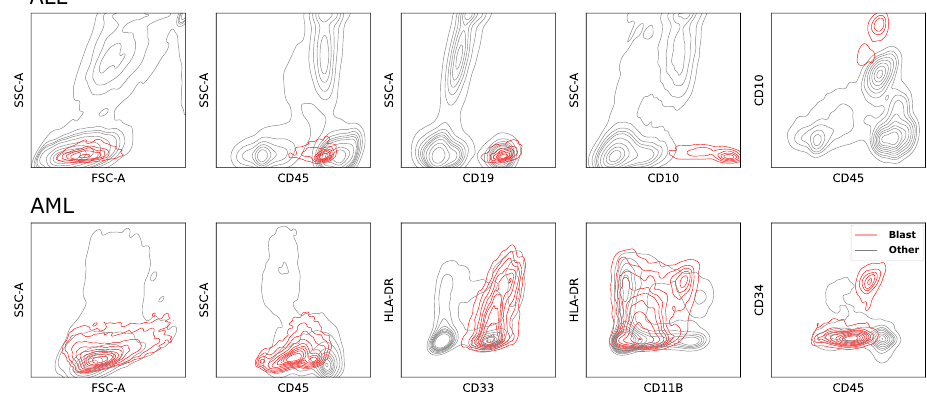
Figure 2. This figure shows the Gaussian kernel density estimation of events pooled together from randomly chosen FCM samples of ALL and AML patients. The density estimation of blasts is shown in red, for normal healthy cell populations grey is used. Blasts are a heterogeneous cell population with varying levels of heterogeneity for different acute leukemia sub-types. In AML samples the blast populations have a larger variance than in